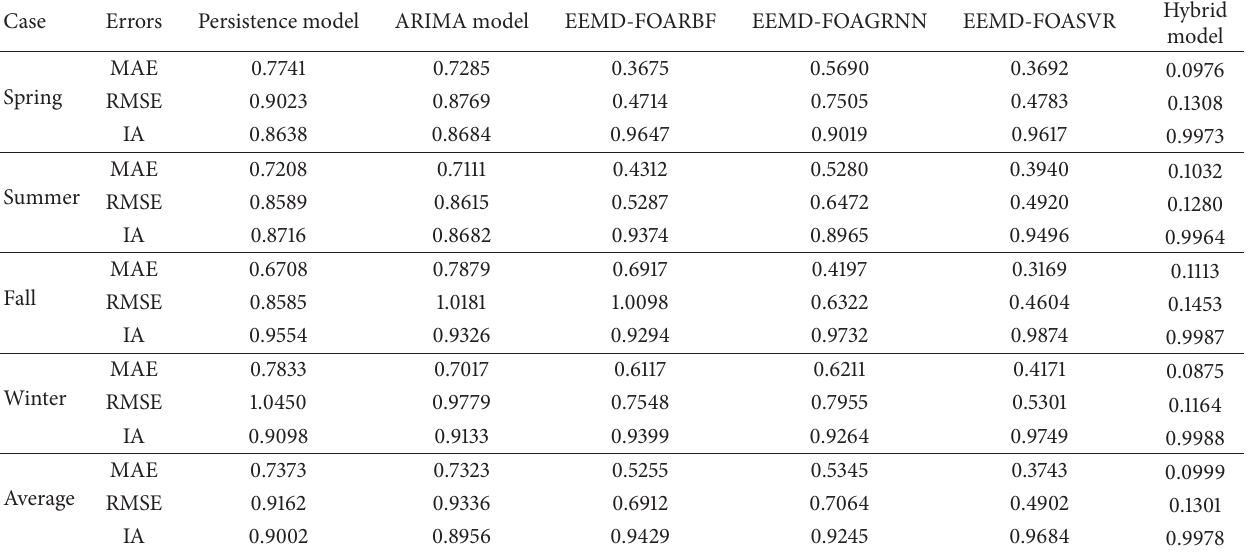
Table 8: The typical results of the hybrid model and the results of the other models for the four seasons.